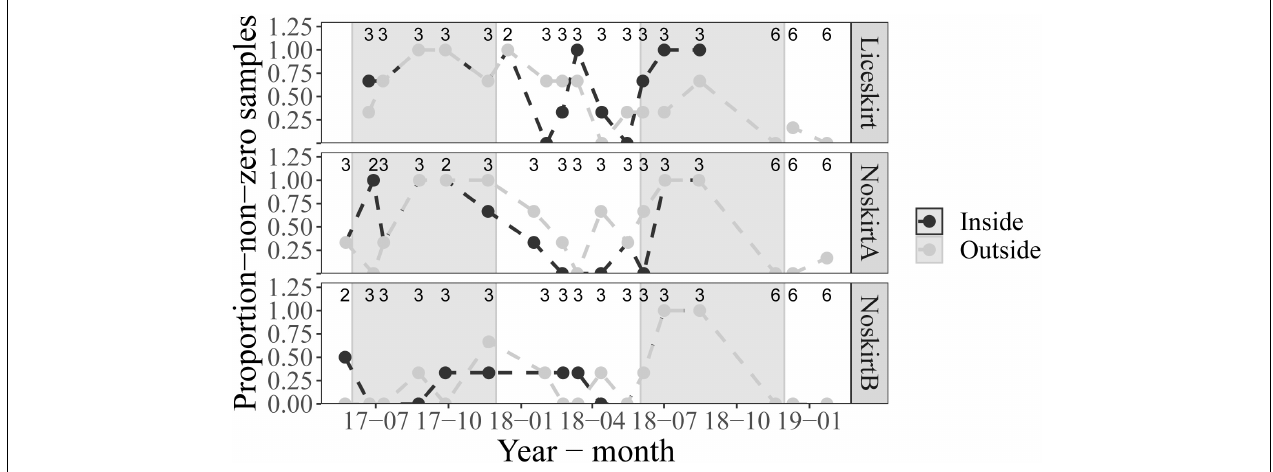
FIGURE 4 | Average proportion-non-zero for the replicate cages (n shown on top of figure) at each locality during the main sampling period and for the six samples taken during the fallowing period. Samples taken on the inside of cages are shown in black, while samples taken on the outside of cages are shown in gray. The background is shaded gray for samples taken during Summer (June–November)